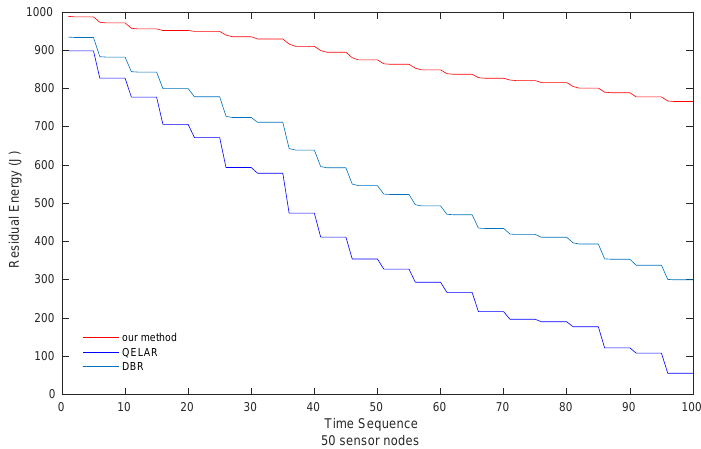
Figure 7. Residual energy of sensor nodes (50 sensor nodes).